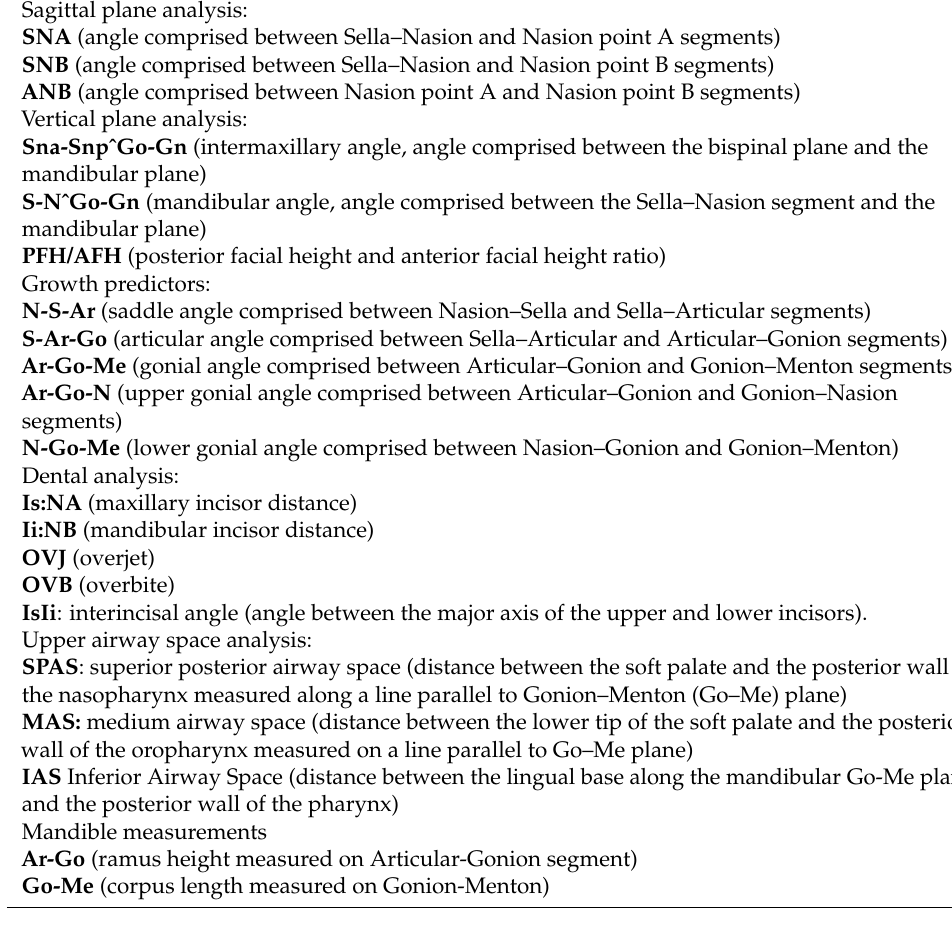
Table 1. All the parameters considered for this study were extracted from the cephalometric